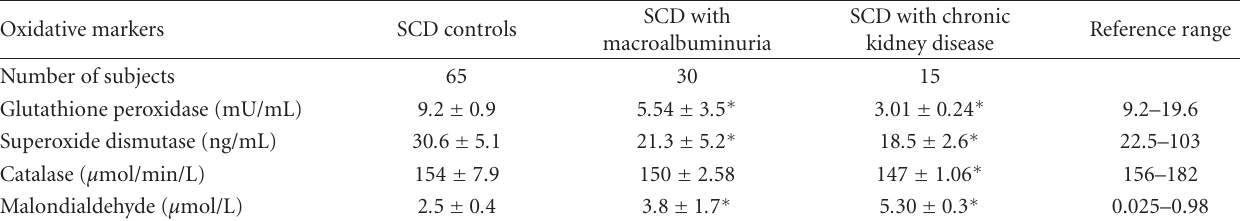
Table 2: Oxidative stress markers of sickle cell disease control, macroalbuminuria, and chronic kidney disease. SCD with Oxidative markers SCD controls